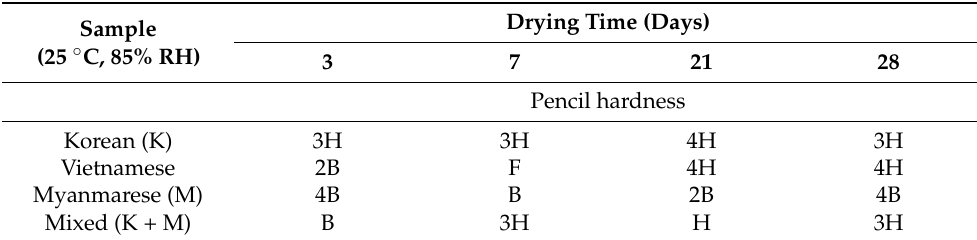
Table 3. Pencil hardness of Oriental lacquer films.